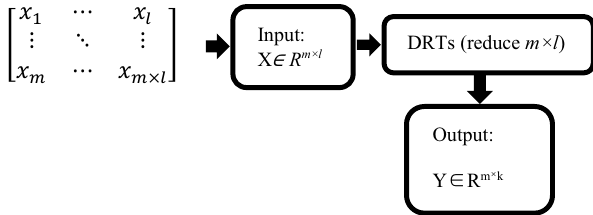
Figure 2. The general structure of DRTs steps where, X is the input corpus (in high dimension), “ m × l ” is the dimension of the X. Also, Y is the output corpus (in low dimension), where “ m × k ” is the dimension after applying DRTs. “ m ” is number of data